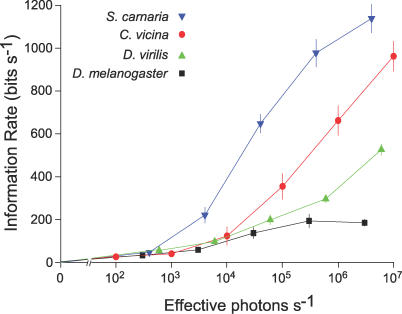
Comparison of Information Rates in R1–6 Photoreceptors from Four Dipteran SpeciesInformation rates (mean ± standard error of the mean) are measured from the response to a randomly modulated light of mean contrast 0.32, presented at five background (average) light levels to: S. carnaria (blue), C. vicina (red), D. virilis (green), and D. melanogaster (black). Each adapting light background was converted to effective photons s−1 to allow the photoreceptors to be compared under equivalent conditions.